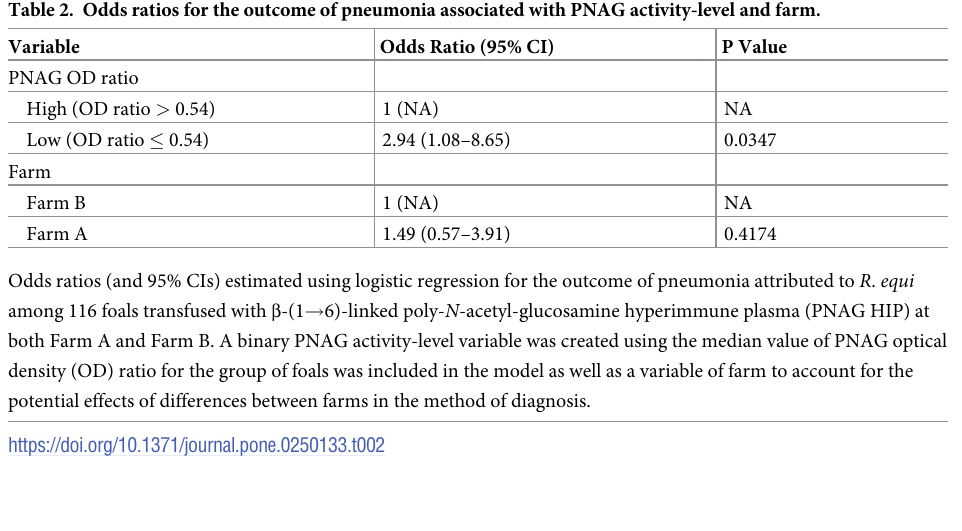
Table 2. Odds ratios for the outcome of pneumonia associated with PNAG activity-level and farm. Variable